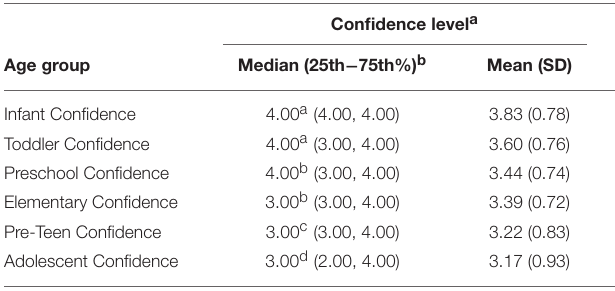
TABLE 5 | Resident parenting questionnaire self-reported median and mean confidence in giving parenting advice by pediatric age group.